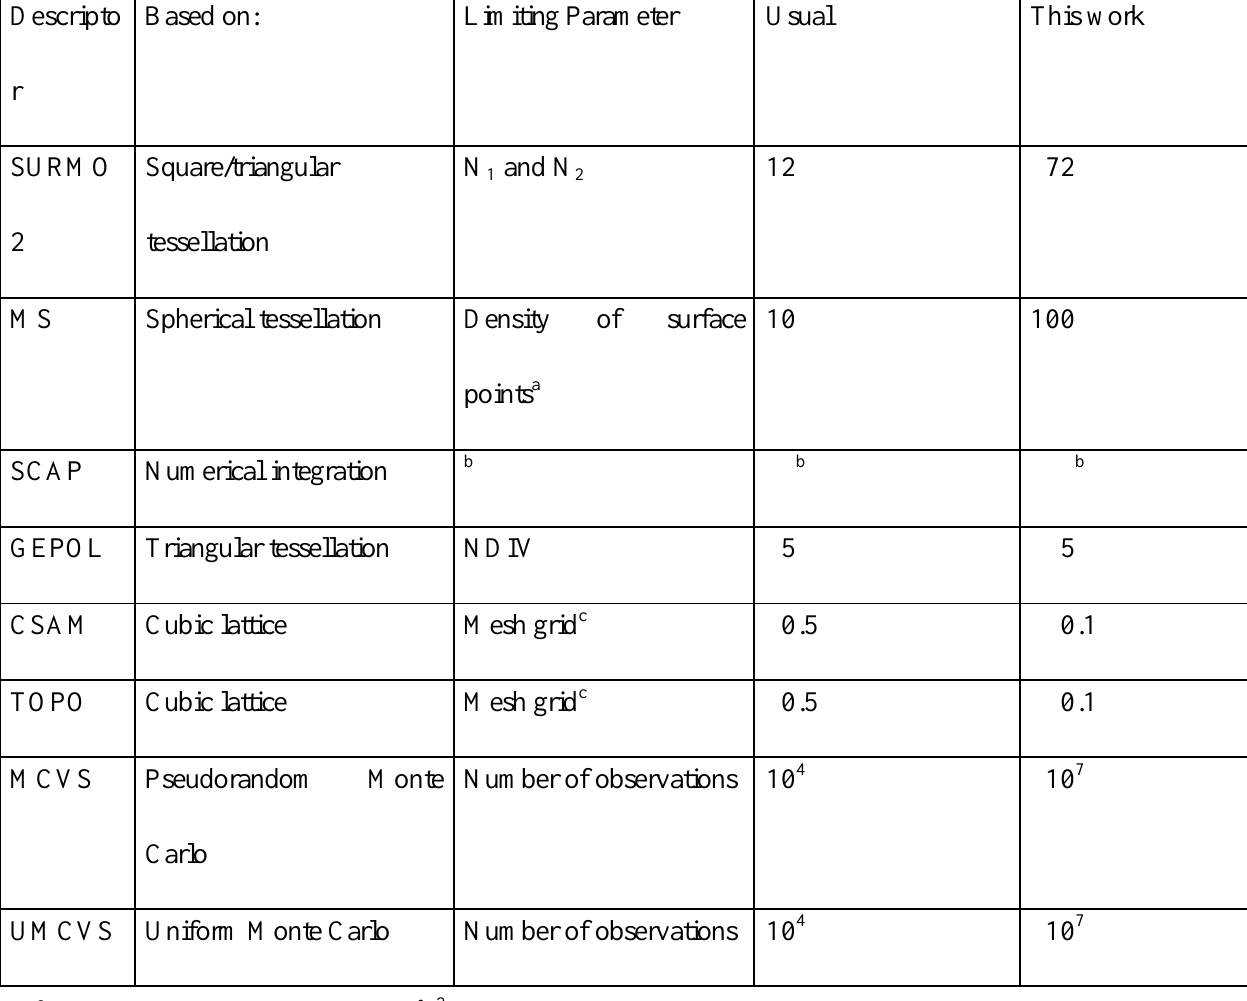
Table 1. Foundations of different programs used to characterize molecular